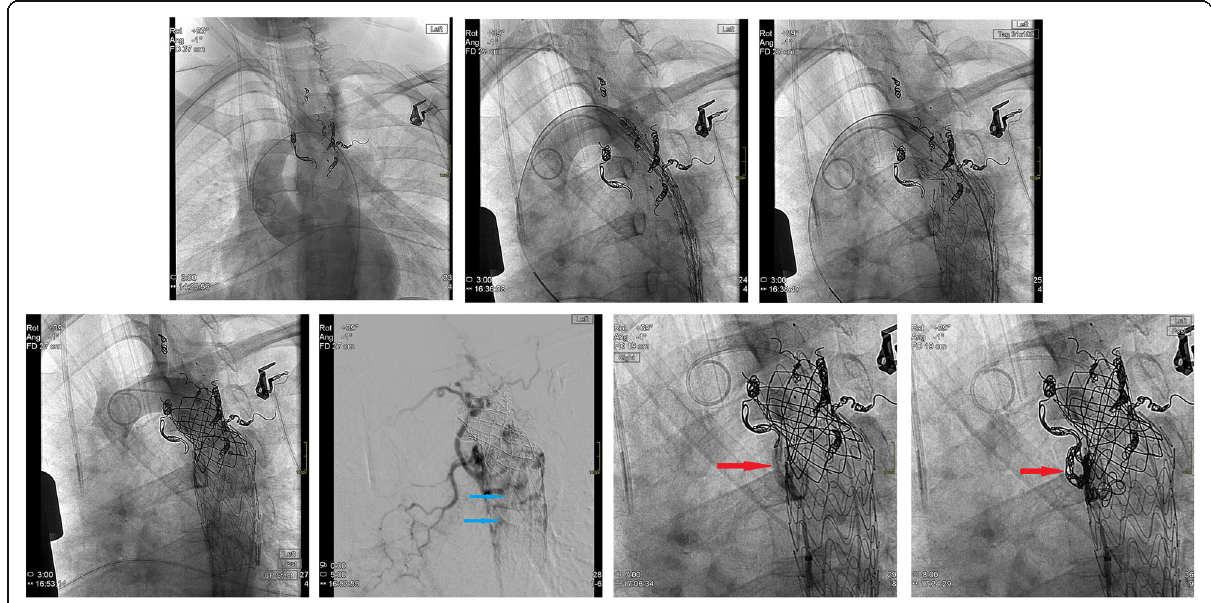
Fig. 5 Image series demonstrating embolisation and stent graft insertion to successfully occlude the aneurysm and dilate the aortic coarctation. Red arrow. represents persisting collaterals pre and post embolisation, Blue arrow corresponds to the position of the jailed